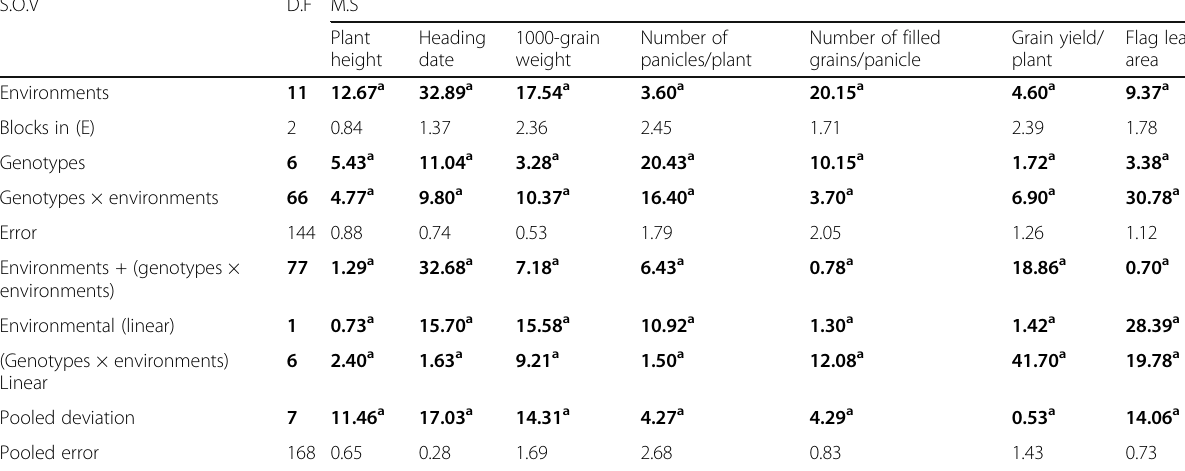
Table 2 Mean squares of all traits evaluated in rice entries during stability analysis